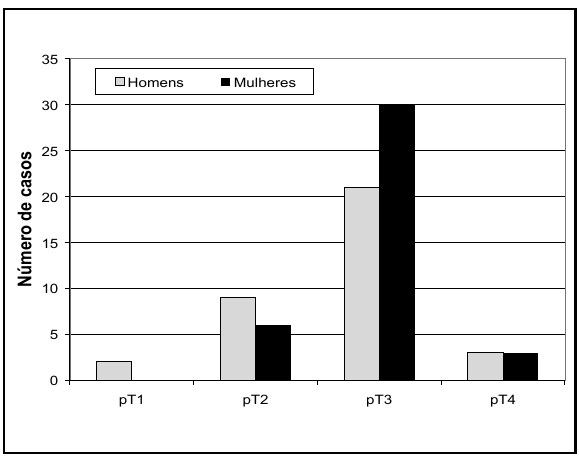
Figura 1 – Distribuição dos casos de carcinoma colorretal quanto ao pT